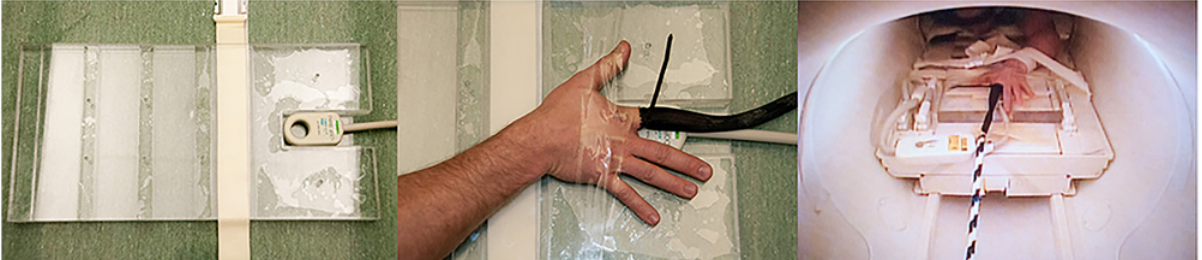
Fig 1. The radiofrequency coil inside the clear housing (left). The metocarpophaangeal (MCP) joint of interest centred over the bore of the radiofrequency coil (middle). The participant ’ s hand within the imaging magnet